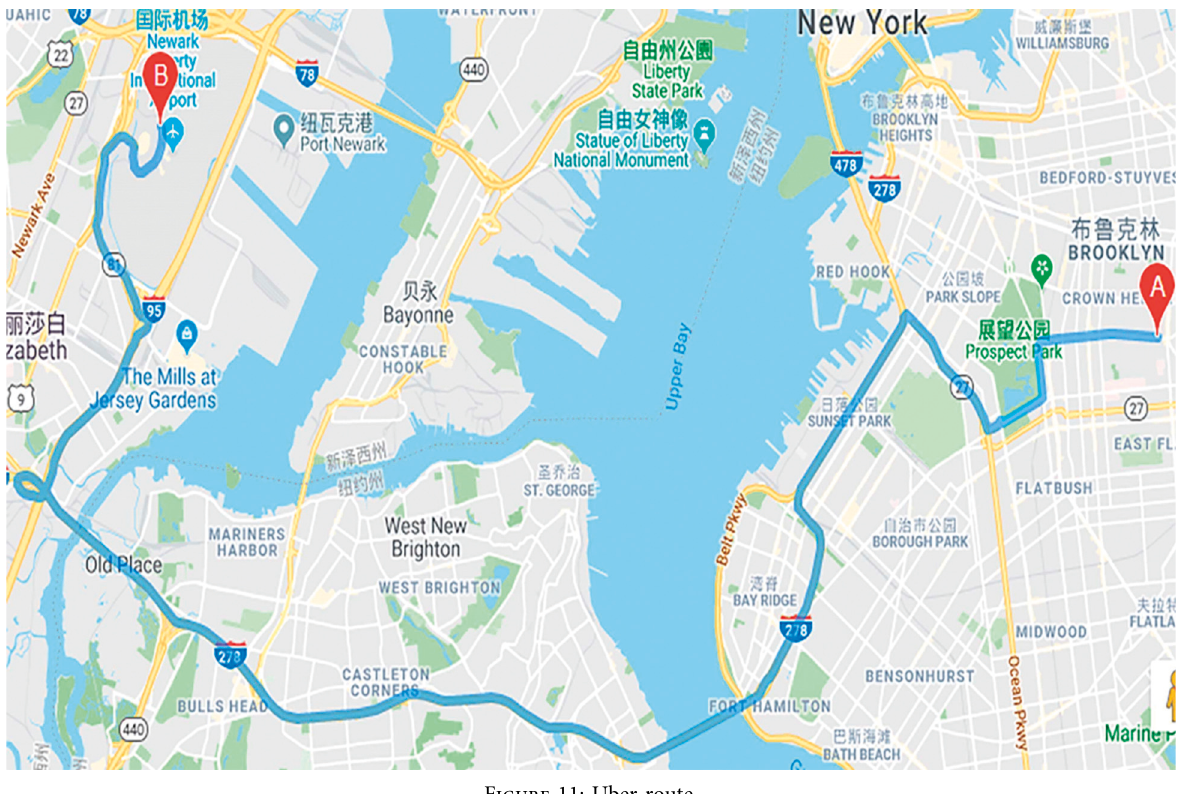
Figure 11: Uber route.